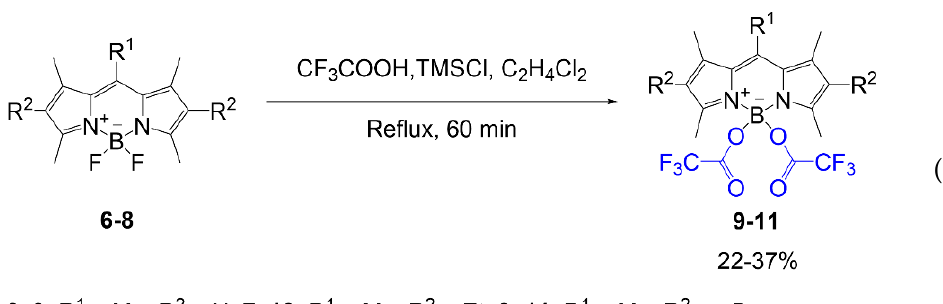
Figure 3. BODIPY with multi-branched fluorinated chains attached to boron center